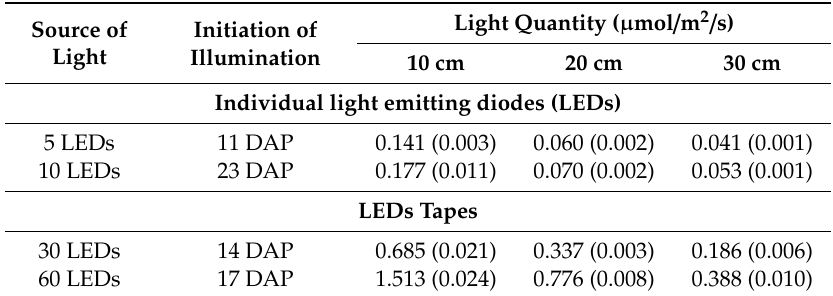
Table 1. Light quantity provided by di ff erent LED sources at 10, 20 and 30 cm (based on five measurements). Within parenthesis are the respective standard deviations. Illumination of plots began at di ff erent days after planting